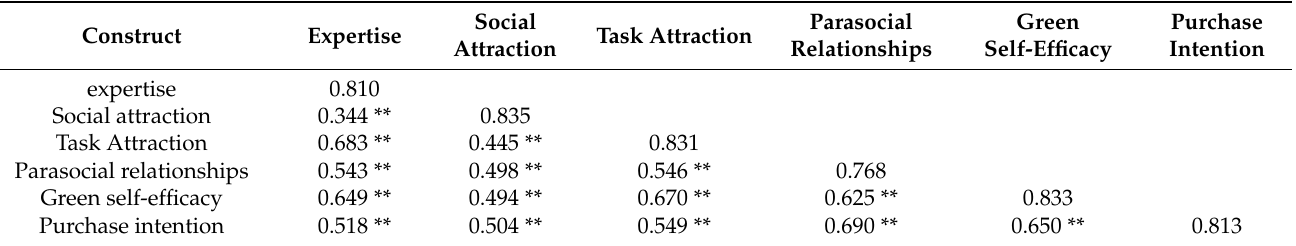
Table 4. Differential validity test results of